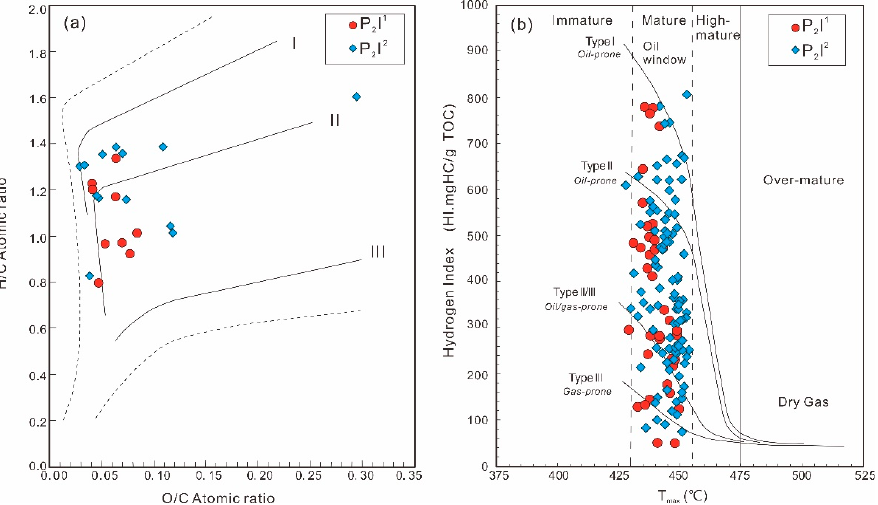
Figure 5. Plots of ( a ) O/C vs. H/C and ( b ) atomic ratio of HI vs. T max showing the organic matter types of the P 2 l source rocks in the Jimsar Depression (H/C, atomic ratio; O/C, atomic ratio; immature; mature; oil generation window; highly mature; condensate oil-wet gas; over-mature; dry gas generation).